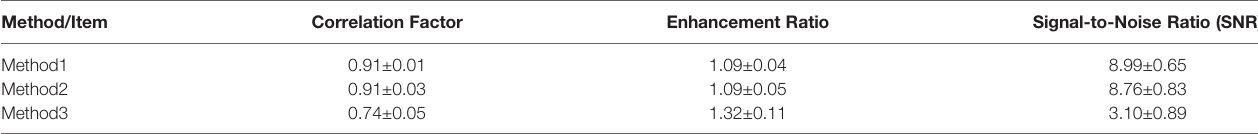
TABLE 2 | Evaluation factors of the enhanced MR images for three